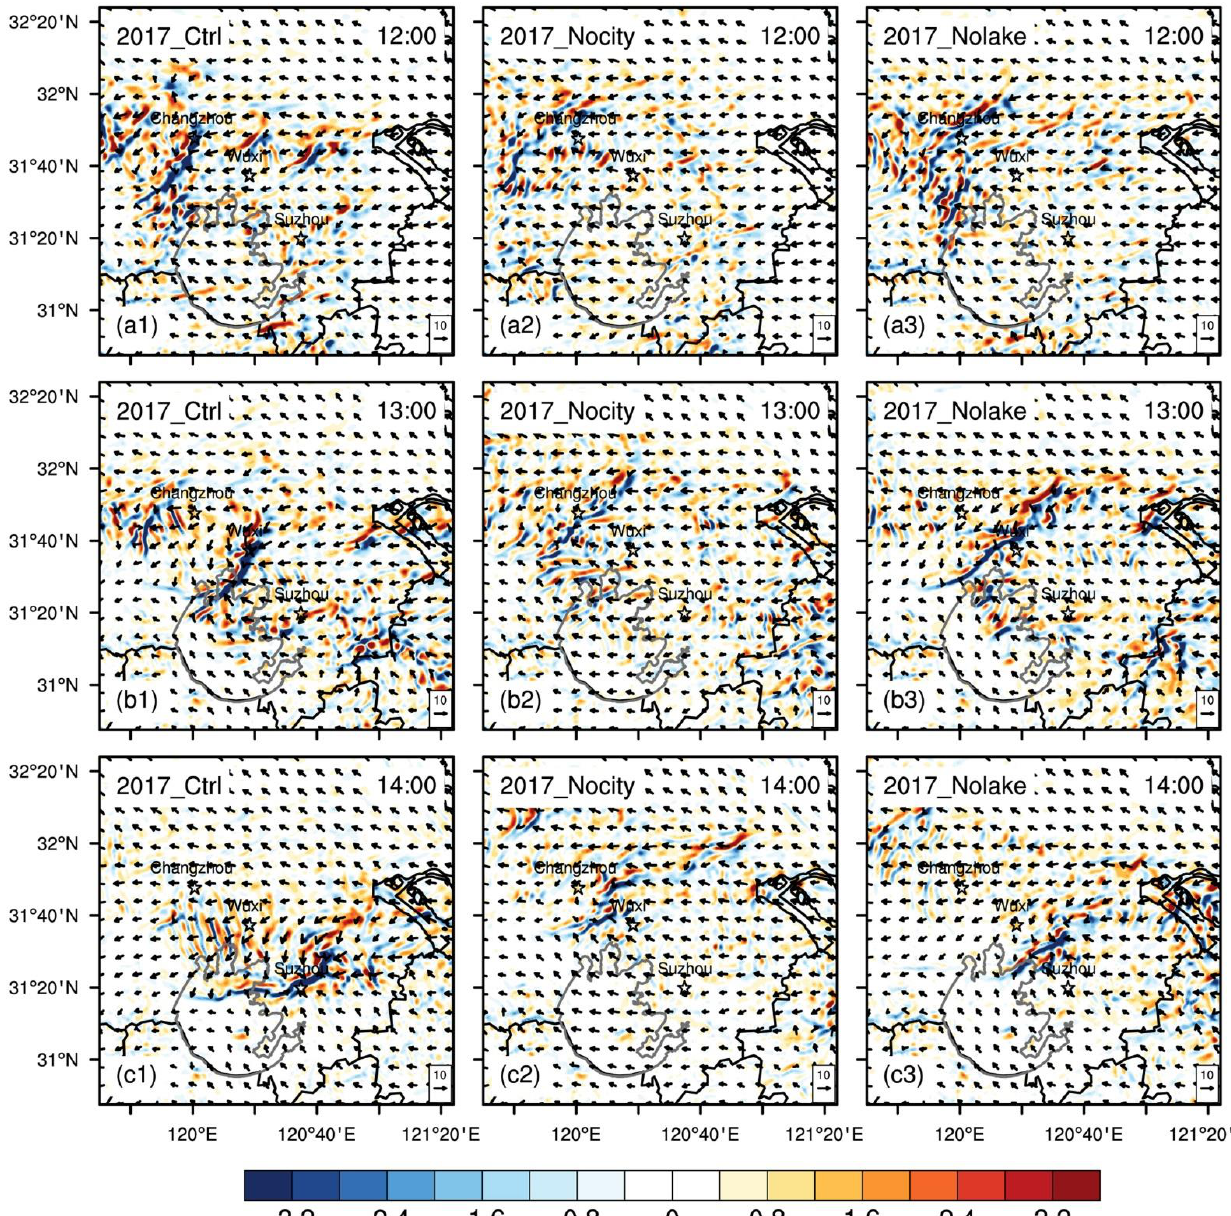
Figure 10. The spatial distributions of the near-surface wind direction and divergence (unit: 10 −3 s −1 ) for the ( a1 , b1 , c1 ) control, ( a2 , b2 , c2 ) Nocity, ( a3 , b3 , c3 ) Nolake runs for EP925.